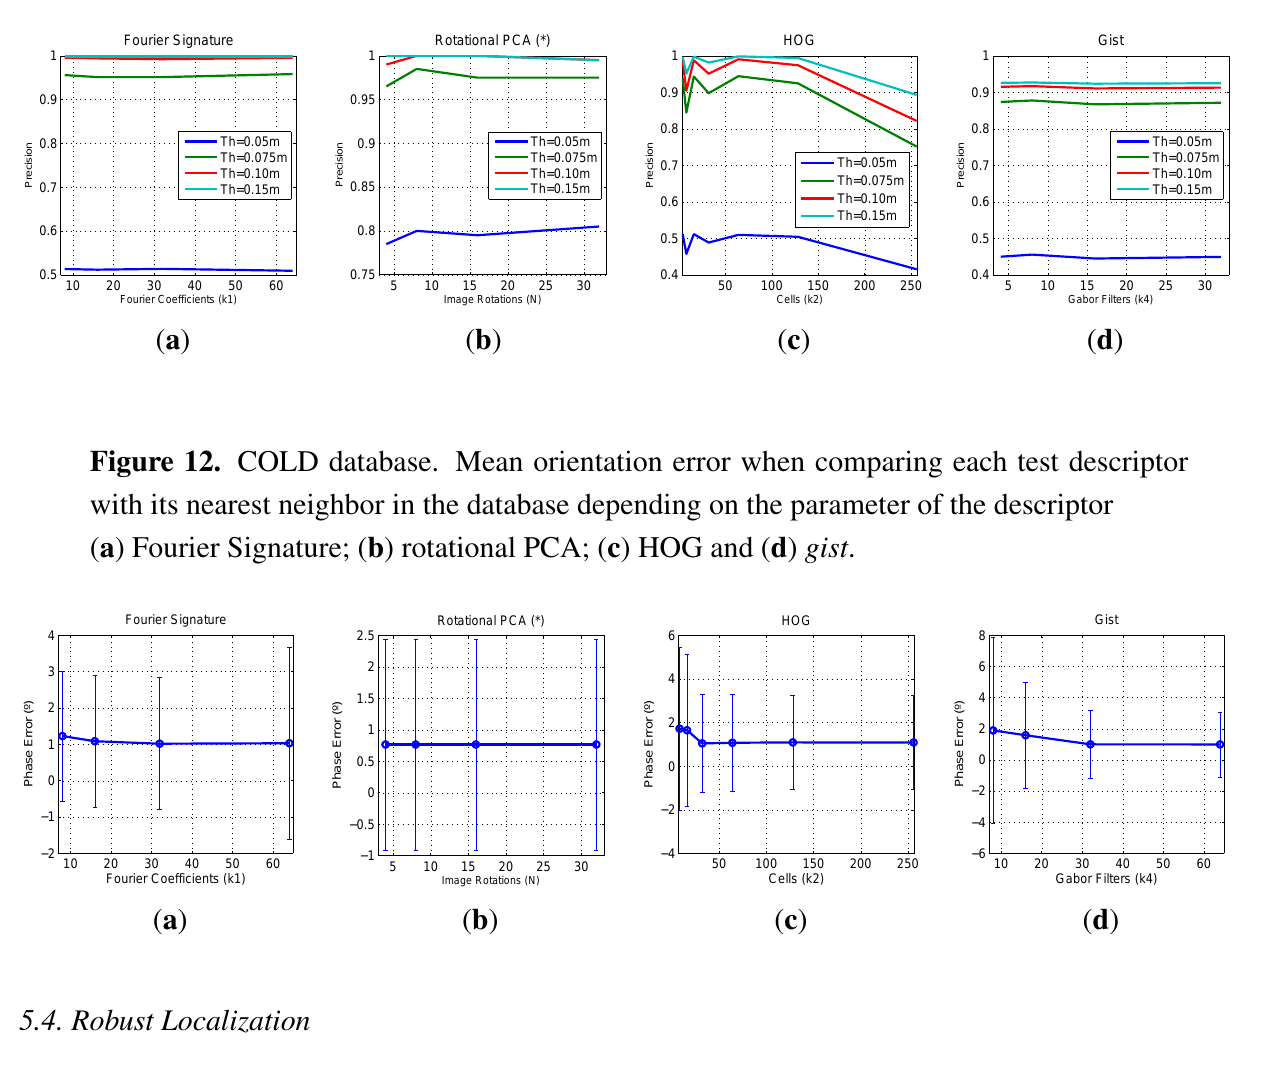
Figure 11. COLD database. Final precision results (expressed in parts per unit) depending on the parameter of each descriptor ( a ) Fourier Signature ( b ) rotational PCA ( c ) HOG and ( d ) gist .